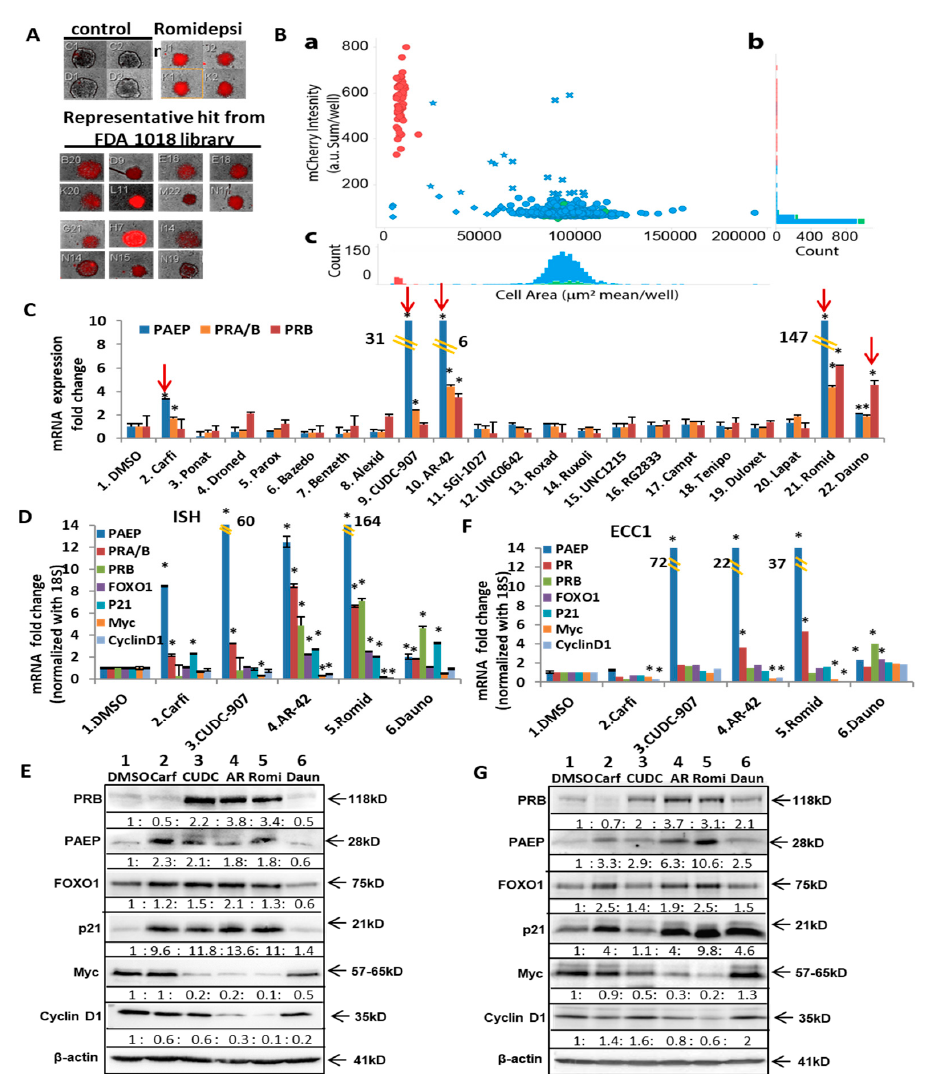
Figure 3. Screening and validation of potential PR inducers selected by High throughput screening of FDA approved drug library. ( A ) Representative mCherry signal in the 3D cultured PR reporter gene-expressing cells treated with FDA approved drugs at 1 µ M. Romidepsin (100 nM) serves as positive control. ( B ) High throughput screening of the FDA approved drug library (Selleck Chem- icals, Houston, TX). a : Scatter plot of all compounds in the screening. Vertical axis: the mCherry intensity (arbitrary unit as sum of mCherry intensity per well). Horizontal axis: area of the spheroids (mean µ m 2 /well). Green as negative control (mock treatment), Red as positive control (romidepsin at 1 µ M), and Blue as the compounds from the library. ✖ : Hits for mCherry intensity increase. ◆ : Hits for area of the spheroid decrease. ★ : Hits for both mCherry intensity increase and area of the spheroid decrease. b : Histogram of mCherry intensity. c : Histogram of area of the spheroids. ( C ) mRNA expression of PAEP, total PR (PRA/B), and PRB after being treated with the initially selected FDA drugs. Cells were treated for 24 h with Carfilzomib (PR-171) [100 nM], Ponatinib